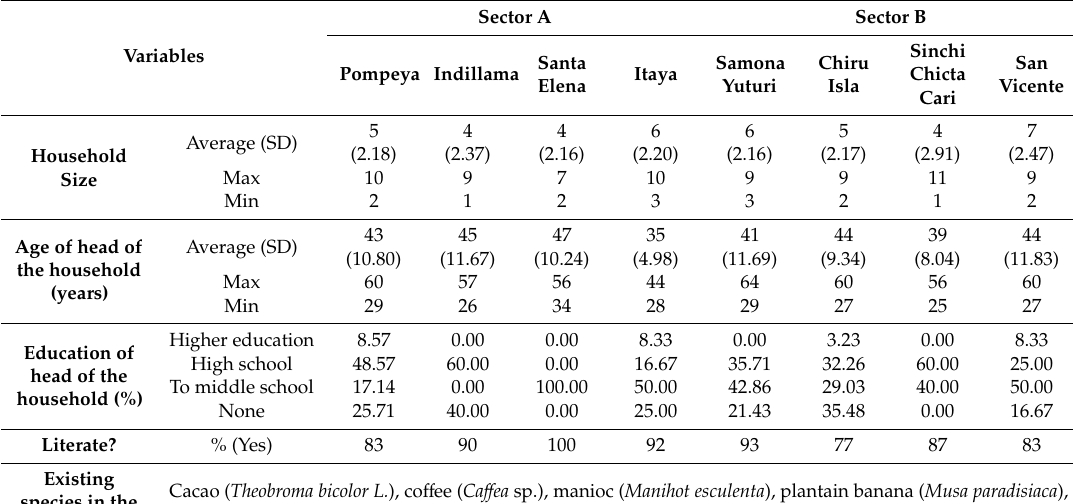
Figure 3. Population pyramid (progressive type) of Kichwas superimposed in the YBR in January 2018. Table 3. Socio-demographic and agricultural characteristics of the Kichwa population by sector and communities in the north of the Yasun í Biosphere Reserve in the Ecuadorian Amazon